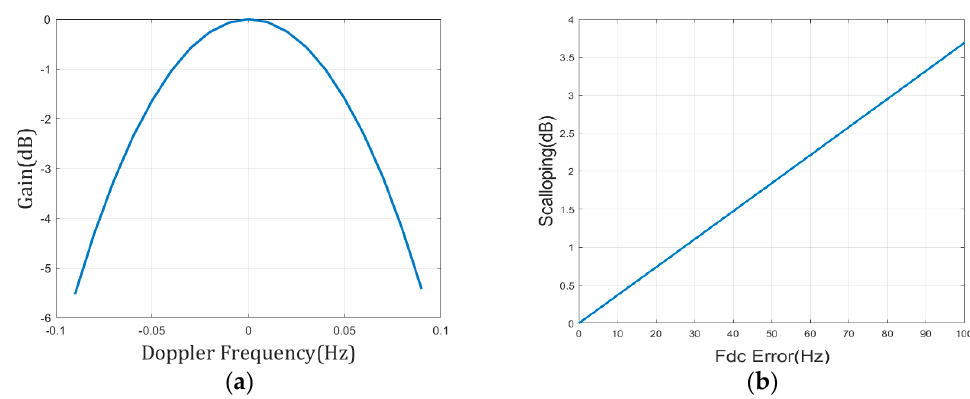
Figure 4. Relationship between azimuth antenna pattern (AAP), Doppler centroid error, and scalloping: ( a ) main lobe of AAP; ( b ) relationship between Doppler centroid error and scalloping.